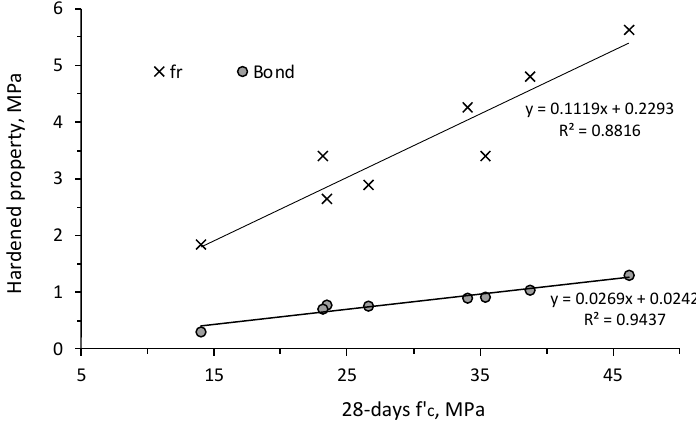
Figure 6. Relationships between the 28 d 𝑓 𝑐′ with respect to 𝑓